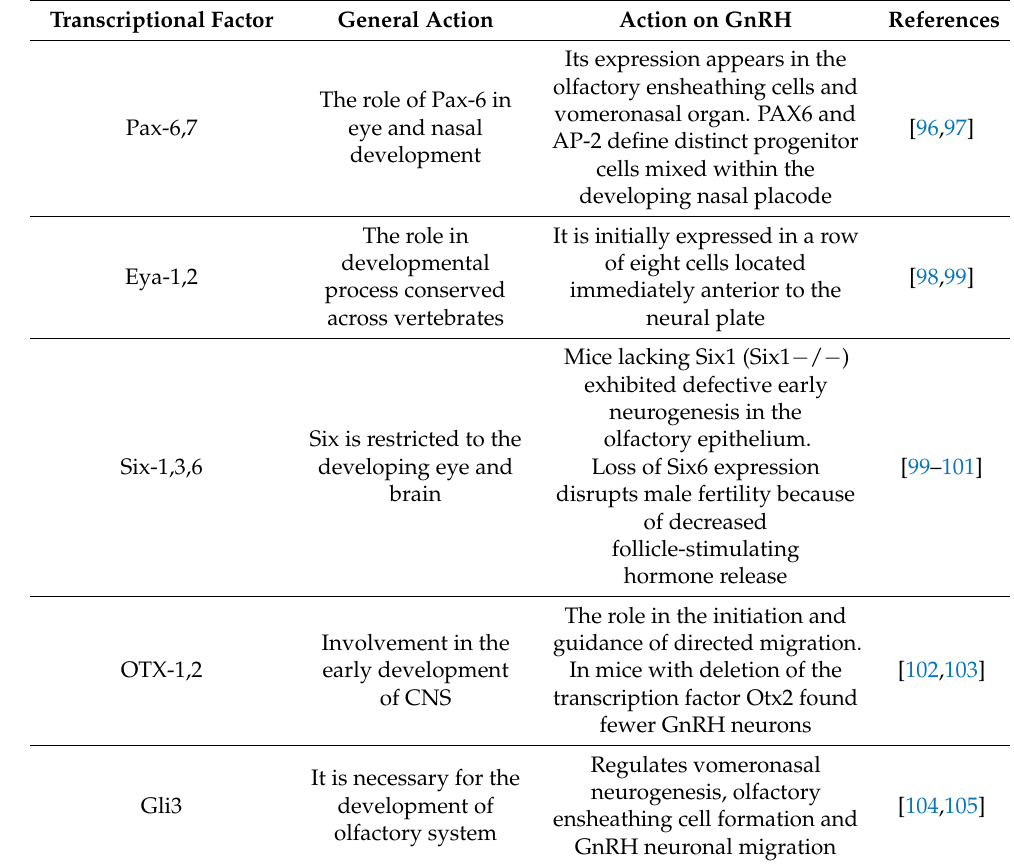
Table 1. The most general transcriptional factors participating in organization of GnRH neuron development and its migratory route